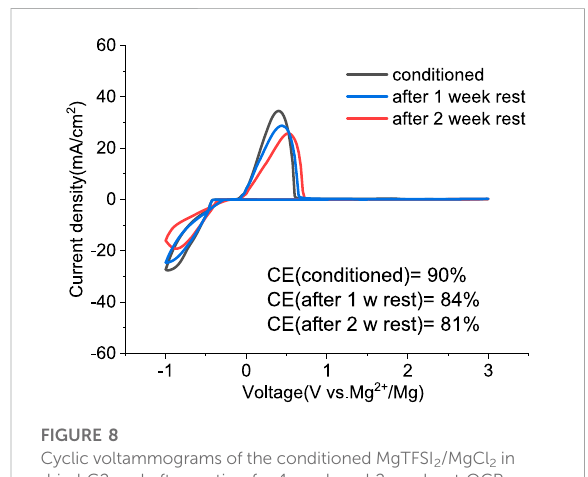
FIGURE 8 Cyclic voltammograms of the conditioned MgTFSI 2 /MgCl 2 in dried G2 and after resting for 1 week and 2 weeks at OCP.